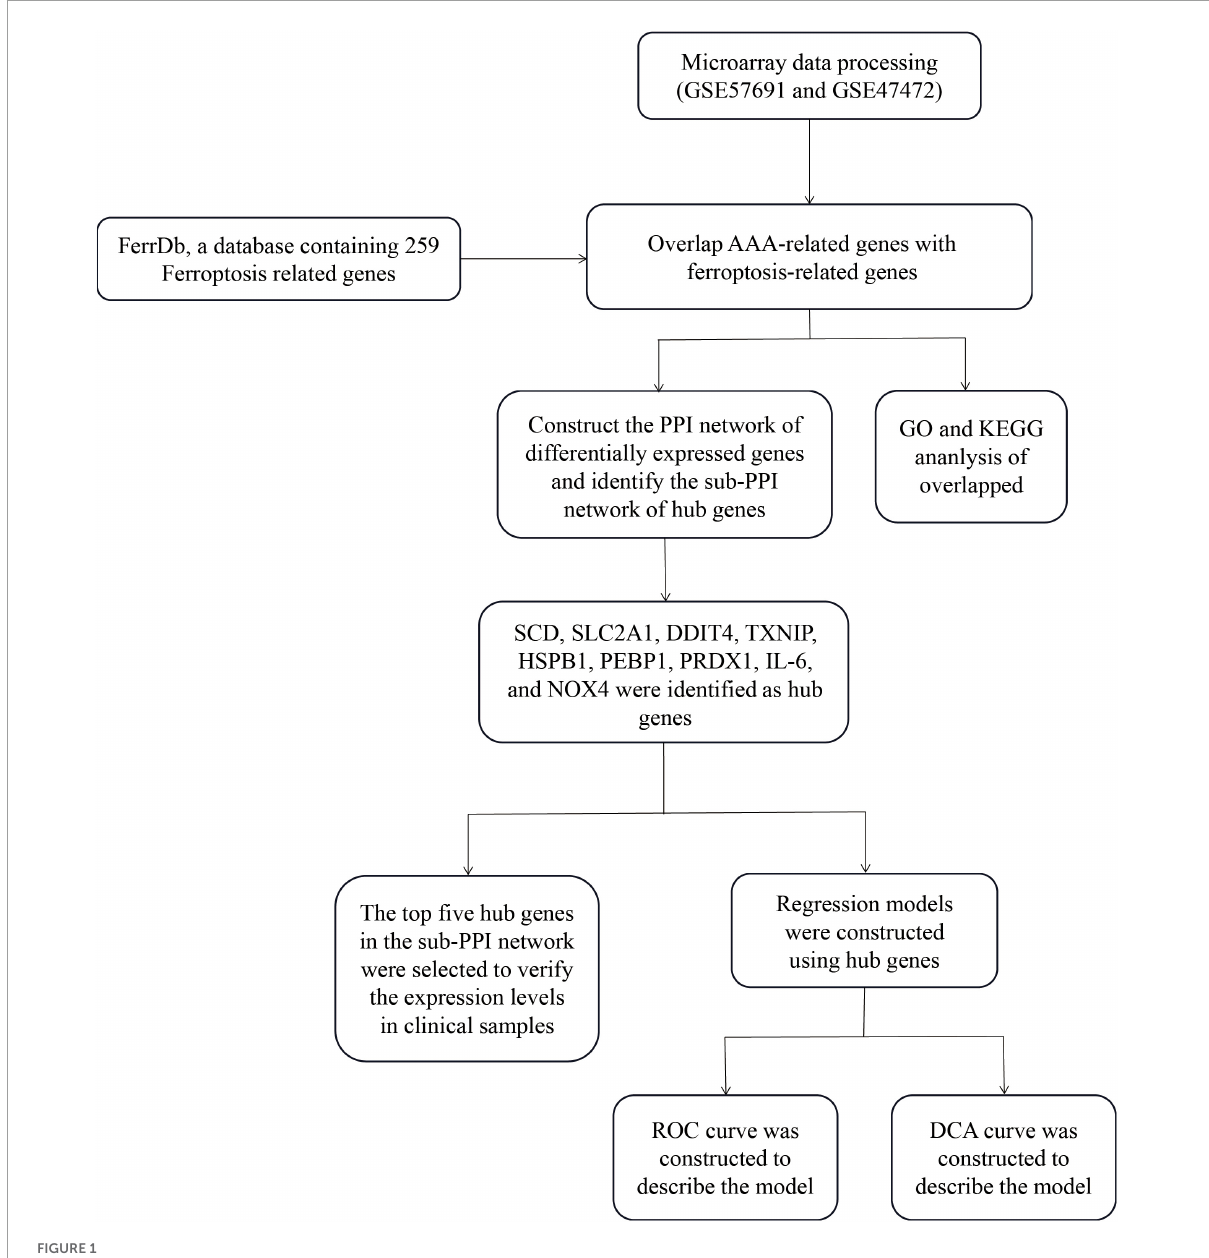
FIGURE1 Workflow of data preparation, processing, analysis, and validation.